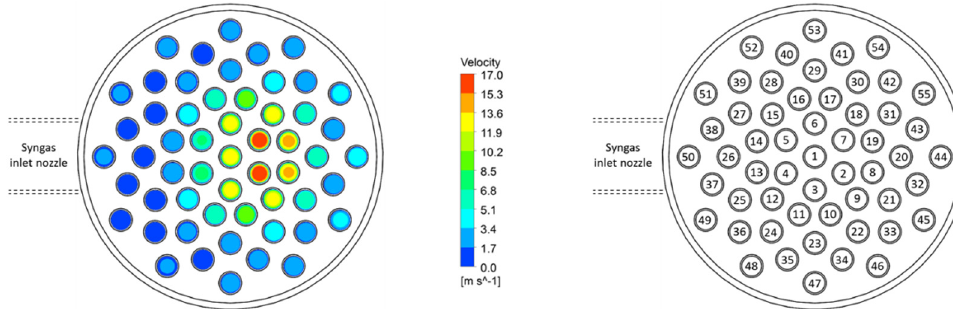
Figure 5. Syngas velocity distribution on a cross-section at the mid-length of the tube bundle for the clean heat exchanger (numbering scheme used to identify tubes reported on the right).